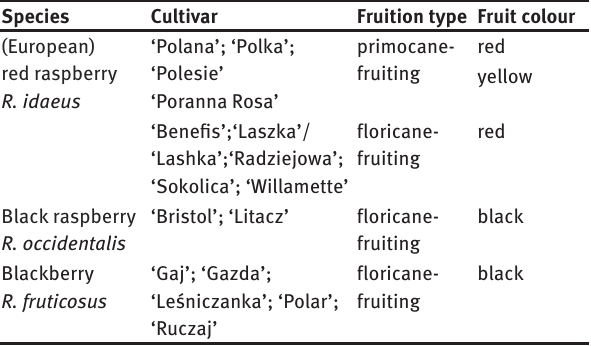
Figure 1: Schematic presentation of the main analytical procedures used in the work. Table 2: The tested raspberry and blackberry cultivars including their fruition type and fruit